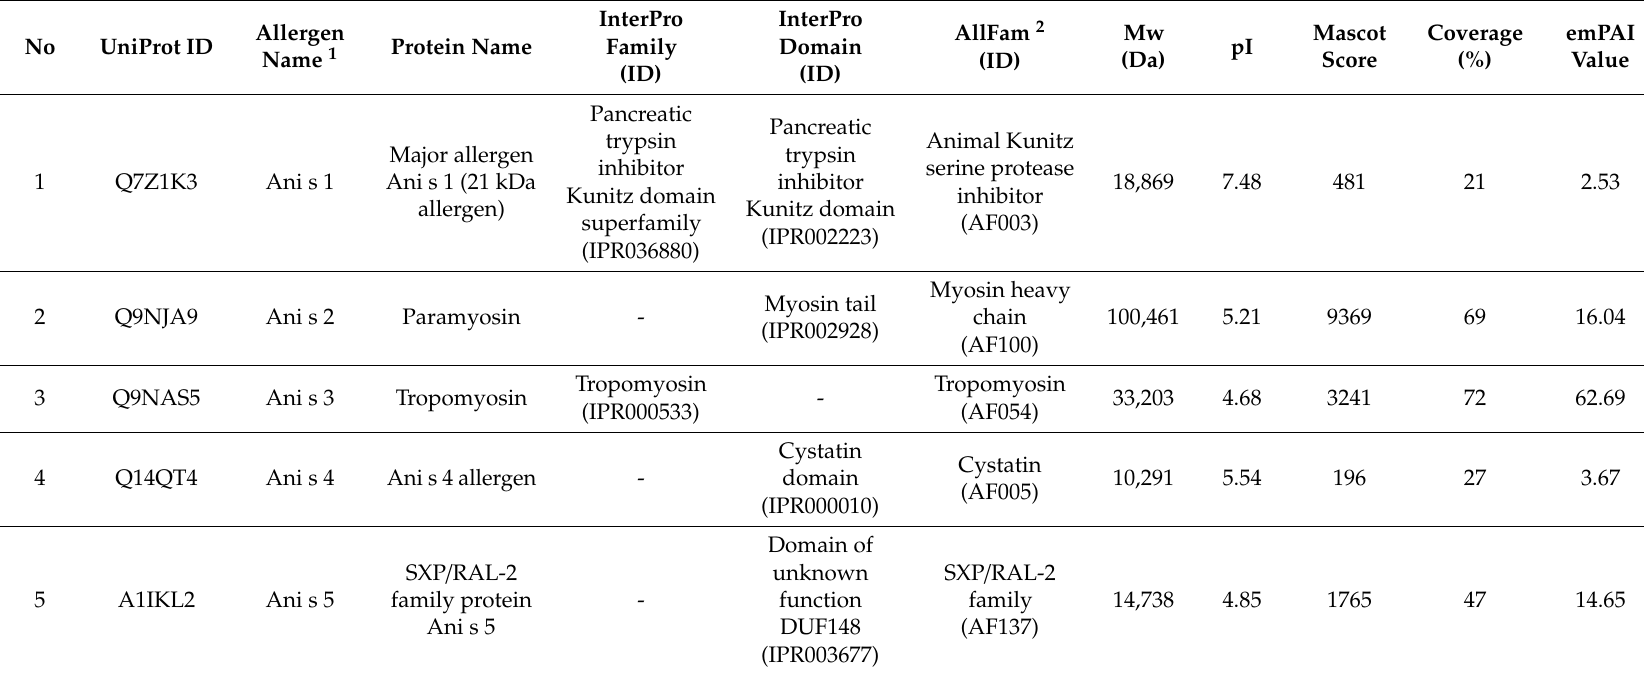
Table 2. Allergens of A. simplex identified using LC-MS /